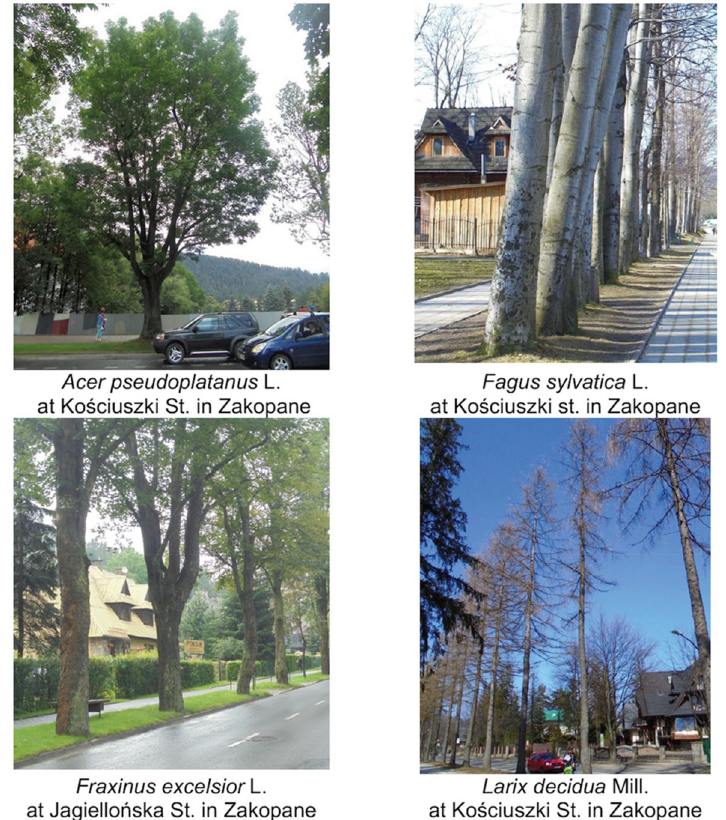
Figure 2. Views of the studied trees ( Source : Marzena